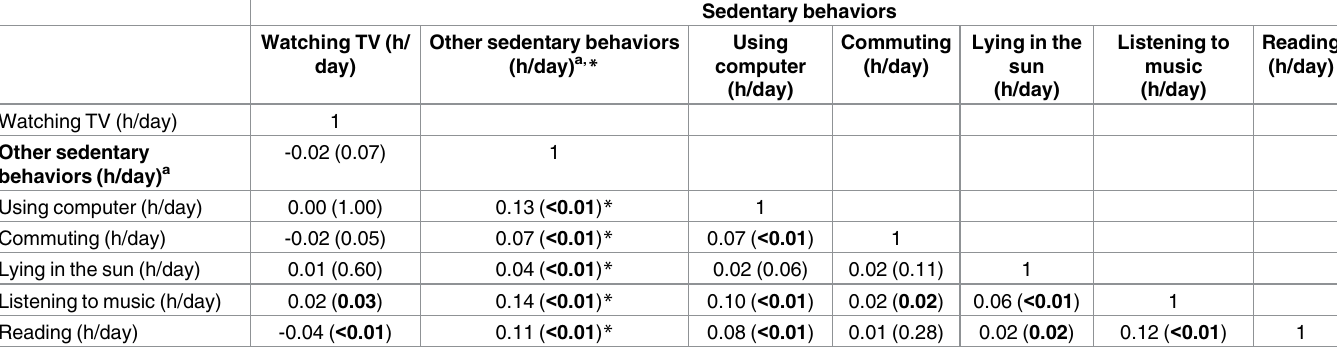
Table 2. Correlations (P-value) between the main sedentary behaviors in the adult population of Spain (ENRICA study, N =